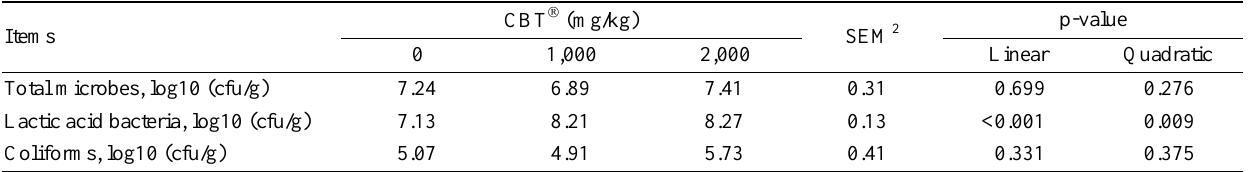
Table 6. Effects of dietary CBT  supplementation on cecal microflora in laying hens 1 Items Total microbes, log10 (cfu/g) Lactic acid bacteria, log10 (cfu/g)